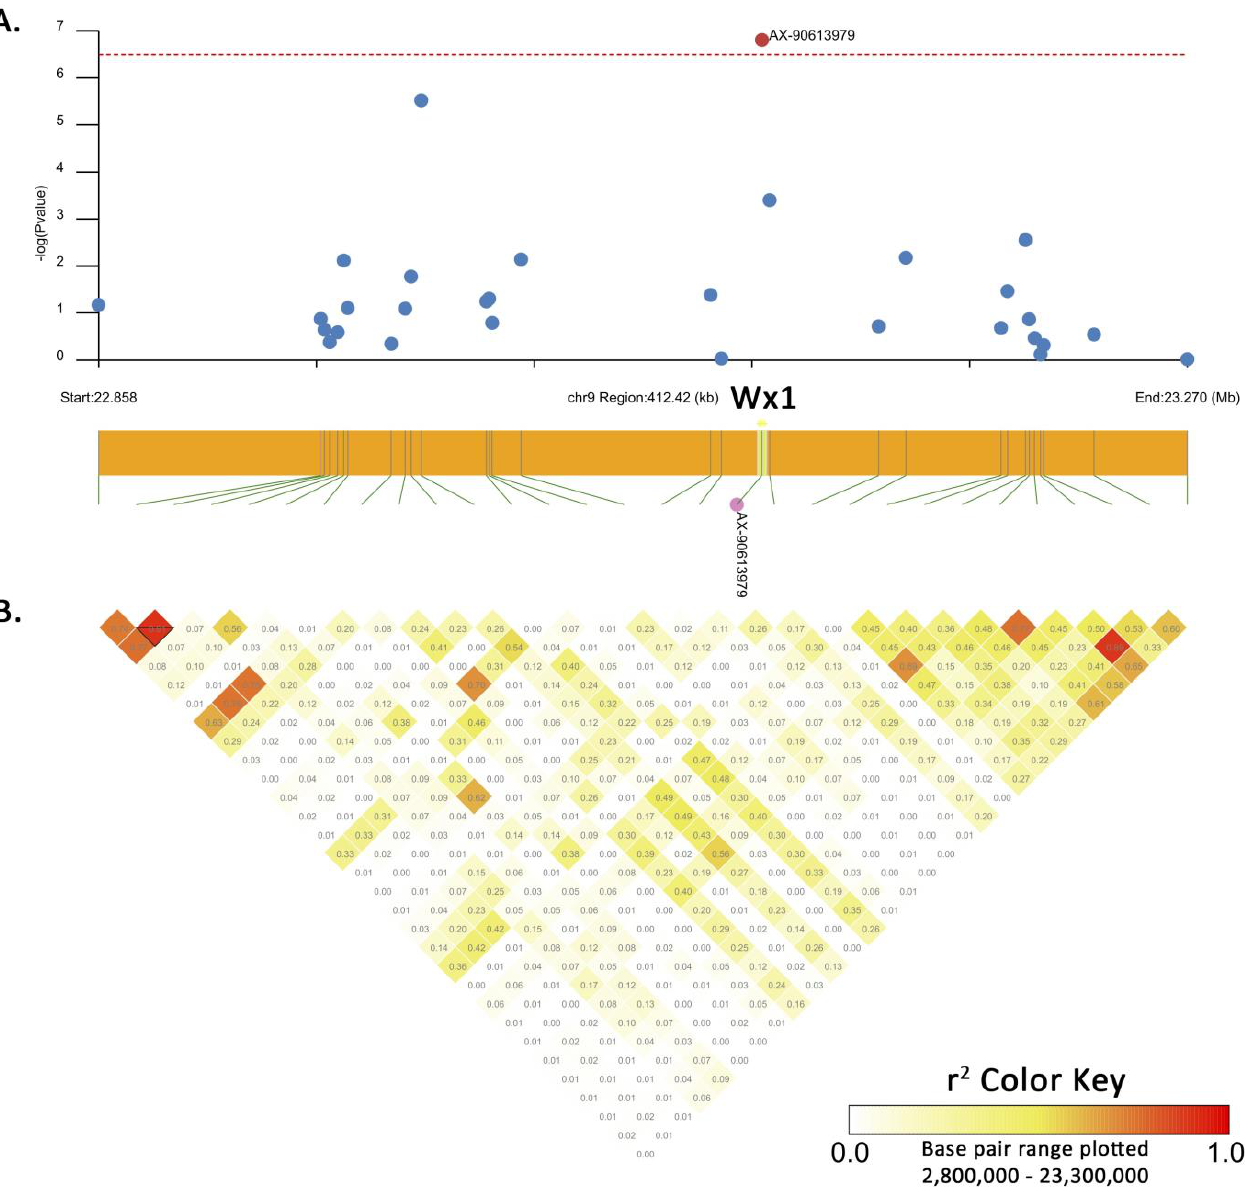
Figure 4. Locus-specific Manhattan plot and LD block analysis for SNPs within the qWx9 region on maize chromosome 9. ( A ) Manhattan plot with significance line (red). ( B ) Heat map with R 2 estimates.